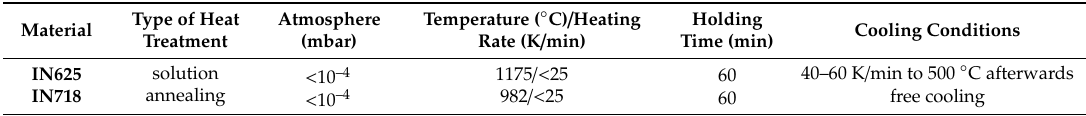
Table 2. Heat treatment parameters.